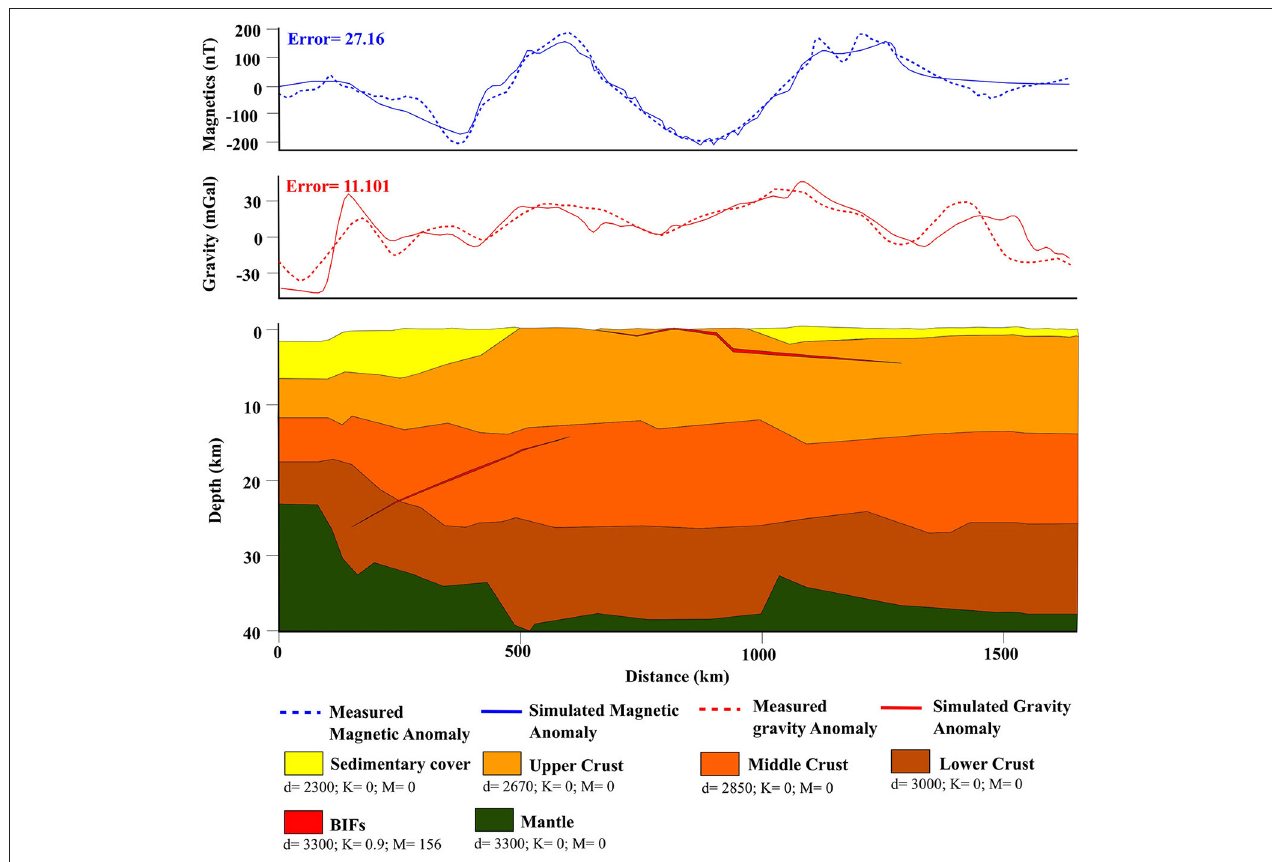
FIGURE 11 | Model of the crustal structure along profile C beneath the WAMA considering deep BIFs with remanence and without magnetic lower crust. The parameters are identical to the ones in Figure 8 .